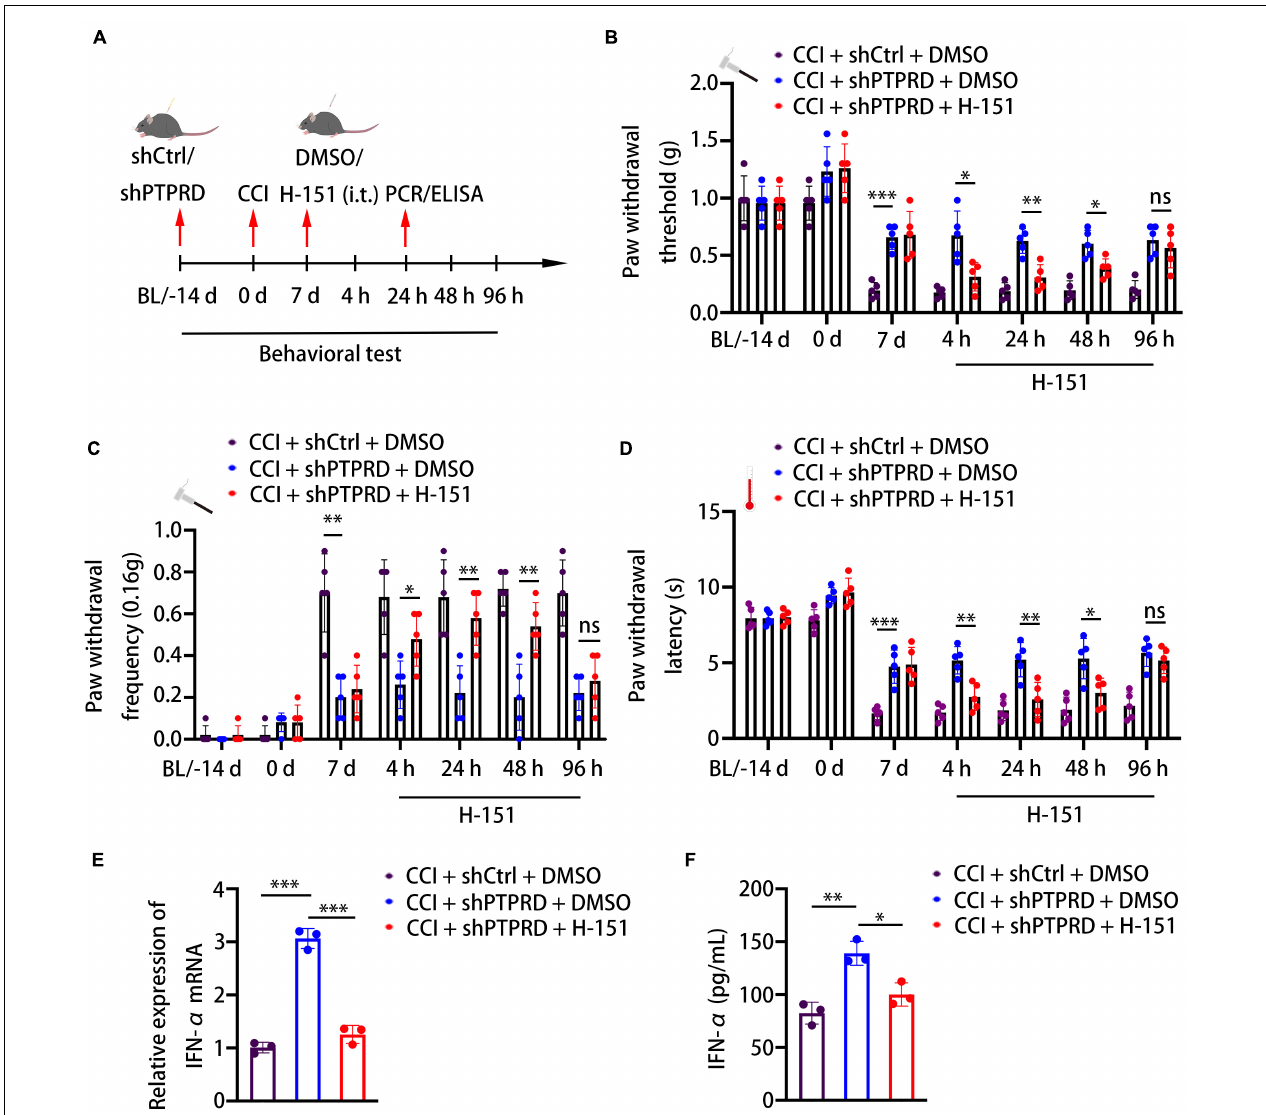
FIGURE 5 | Protein tyrosine phosphatase receptor type D regulates CCI-induced neuropathic pain via the STING-IFN- α pathway. (A) Schedule of the virus injection, surgery, STING inhibitor (H-151, 10 nM, i.t.) administration, behavioral testing, qRT-PCR, and ELISA. (B–D) Paw withdrawal threshold, paw withdrawal latency, and paw withdrawal frequency before virus injection (BL), the day of surgery, 7 days after the surgery, or 4, 24, 48, and 96 h after H-151 treatment. N = 5 mice per group, ∗ p < 0.05, ∗∗ p < 0.01, ∗∗∗ p < 0.001. (E) qRT-PCR analysis of the relative expression of IFN- α . N = 3, ∗∗∗ p < 0.001. (F) ELISA analysis of the expression of IFN- α . N = 3, ∗ p < 0.05, ∗∗ p < 0.01. Statistical comparisons were performed using two-way ANOVA with Tukey’s post hoc test (B–D) or unpaired Student’s t -test (E,F)